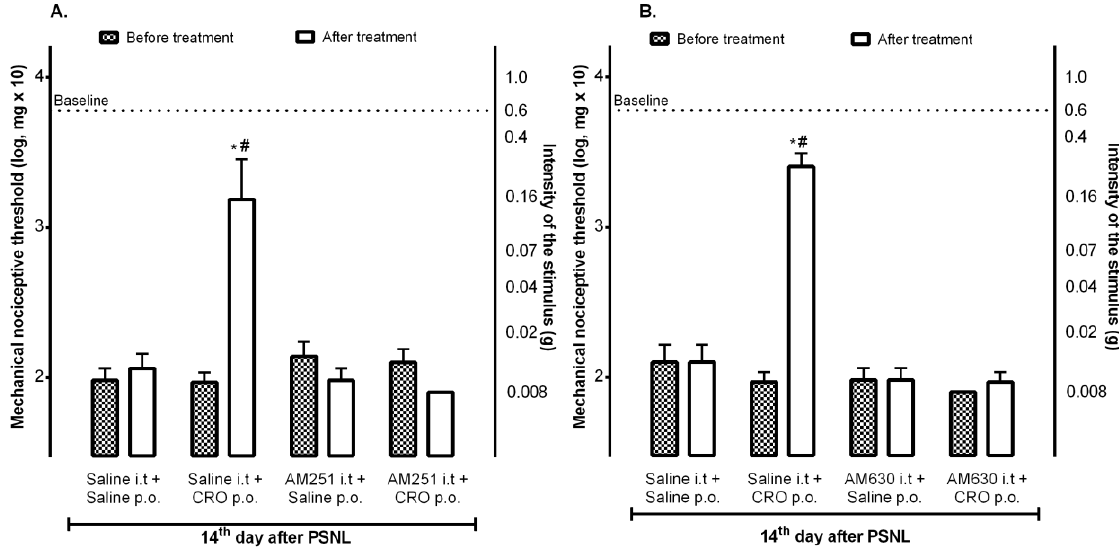
Figure 2. Participation of central cannabinoid receptors in the analgesic effect of crotalphine. On the 14th day after the partial sciatic nerve injury (PSNL) surgery, 10 min before crotalphine (CRO), mice were treated (i.t.) with AM251 (10 µ g/10 µ L) ( A ) or AM630 (2 µ g/10 µ L) ( B ), following the CRO (100 µ g/kg, p.o.). The nociceptive threshold was evaluated using von Frey filaments one hour after CRO treatment. The results are expressed by the mean of ( ± EPM). n = 6. * p < 0.05 statistically significant when compared to the PSNL + Saline p.o. or PSNL + Saline i.t. + Saline p.o; # PSNL + AM251 or AM630 i.t. + CRO p.o. before and after treatment. The two-way ANOVA